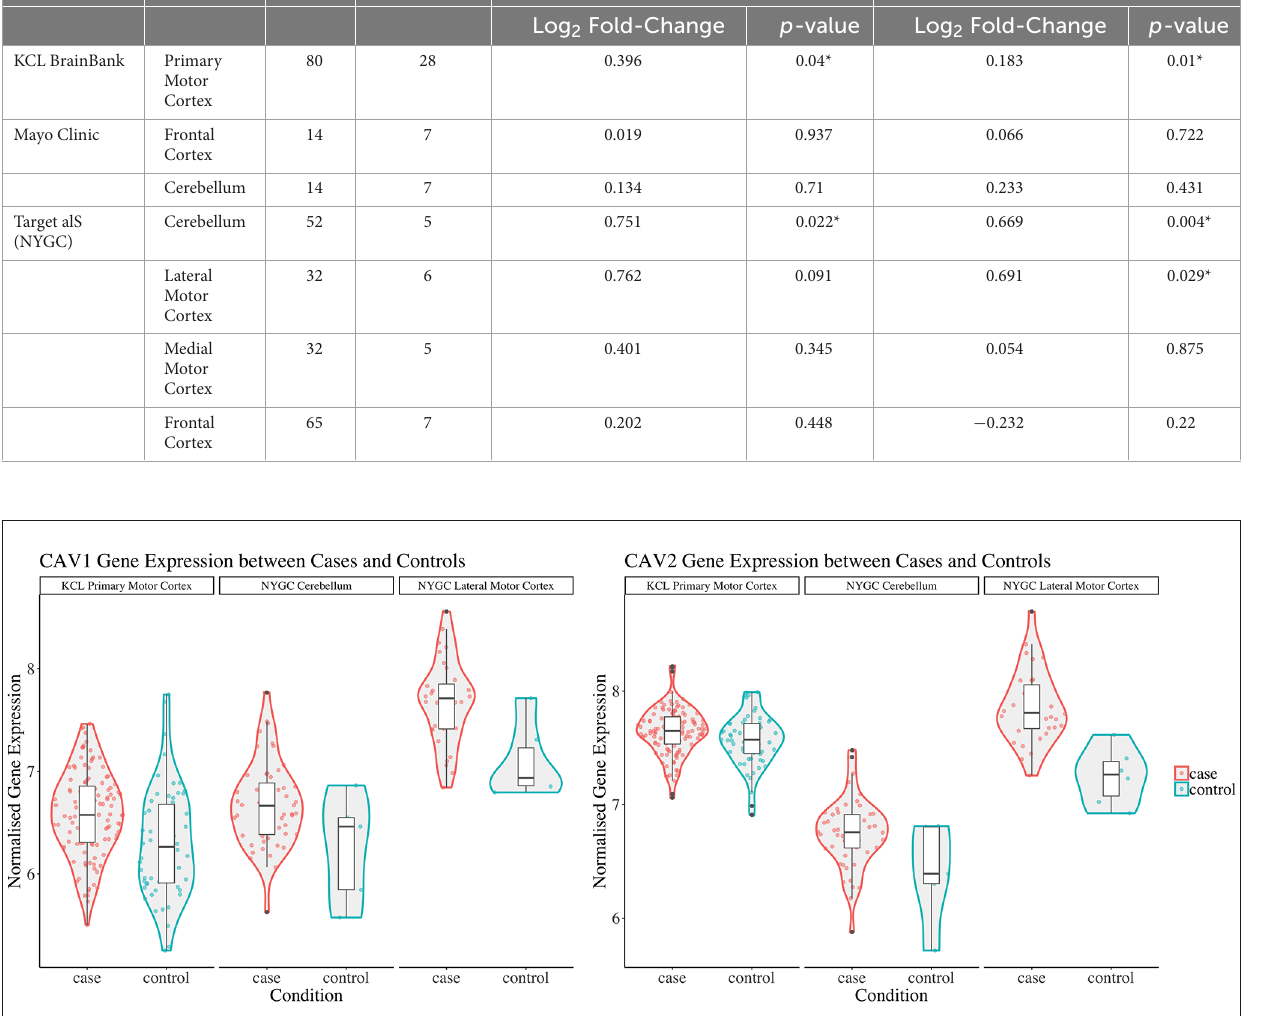
expression of CAV1 and CAV2 might represent a